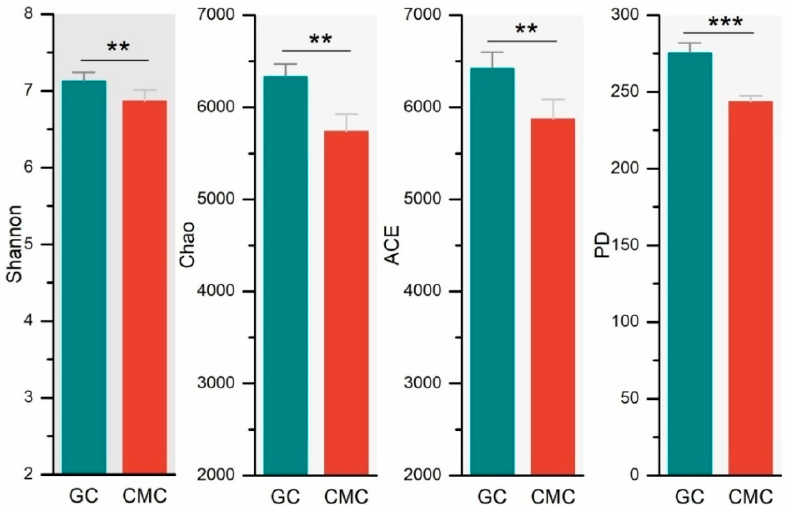
Figure 3. Bacterial richness and diversity for the sediments collected from the ponds with different aquaculture practices. See Figure 1 for abbreviations. ** p < 0.01; *** p < 0.001.